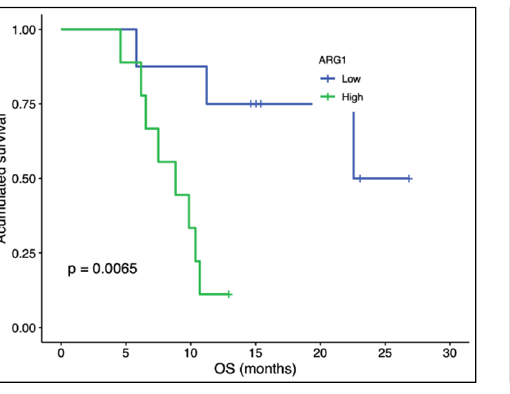
Figure 2. Expression changes produced by targeted therapy.